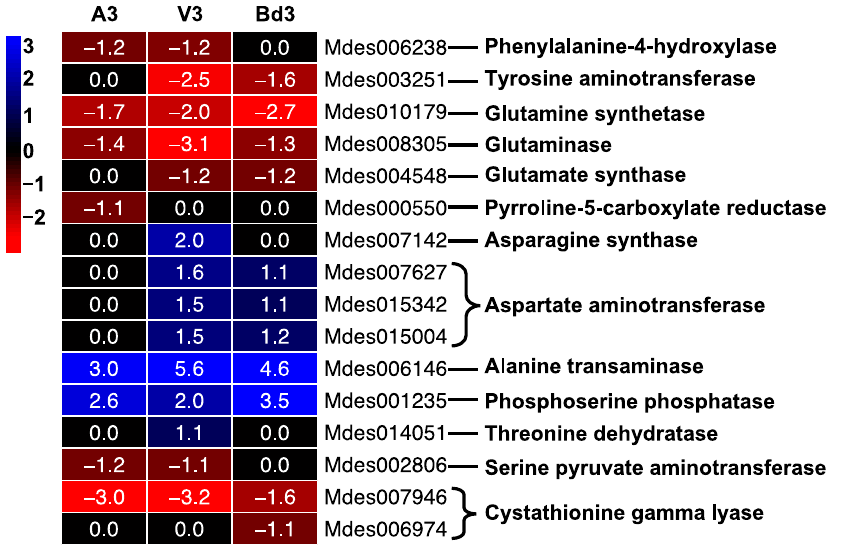
Figure 13. Differential expression of genes from the nonessential amino acid biosynthetic pathway (NAABP) in Hessian fly larvae 3 days after hatch (DAH). Heatmap depicts differential expression trends of genes that are part of synthesis of nonessential amino acids in avirulent (A3), virulent (V3), and Bd3 larval transcriptomes. Log2 fold-change RNA-Seq values are shown within each cell of the heatmap. Blue represents up-regulated genes, and red represents the down-regulated genes, while genes not differentially expressed at a particular time-point are indicated in black.